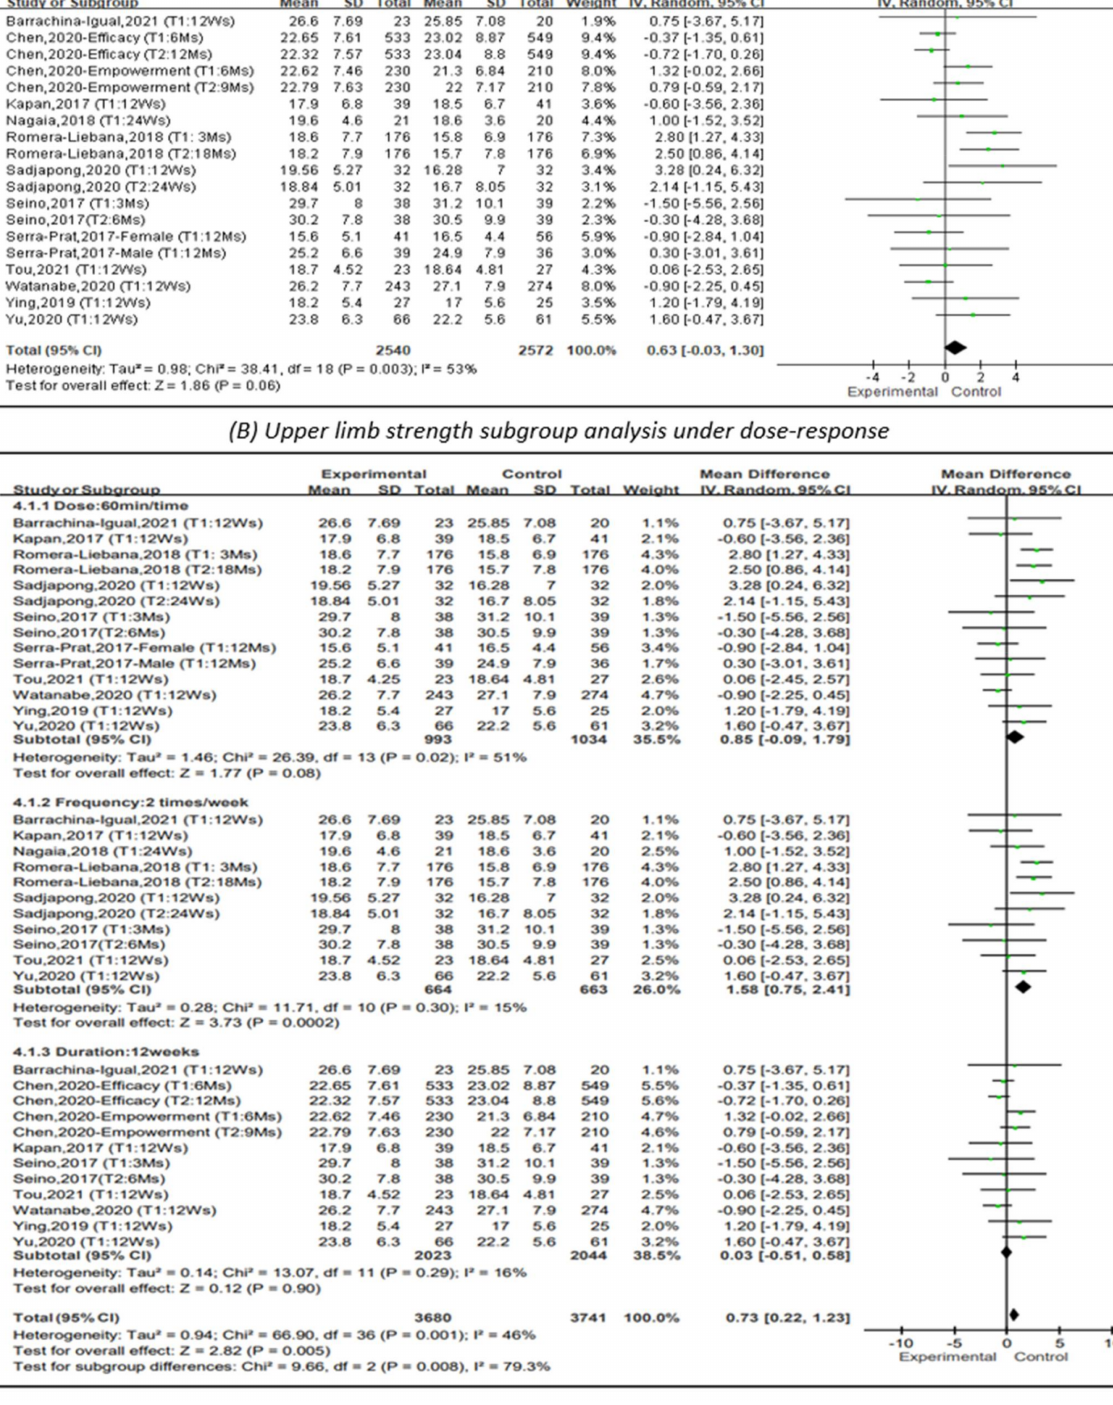
Figure 5. Forest plot of effects on upper limb strength and subgroup analysis for dose-response. The size of the green square represents the weight of the study in the meta-analysis. The rhombus represents the combined OR. OR = odds